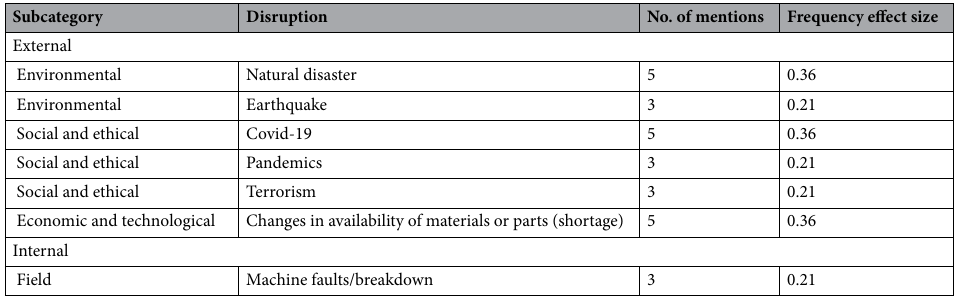
Table 4. Effective findings (frequency effect size over 20%) of